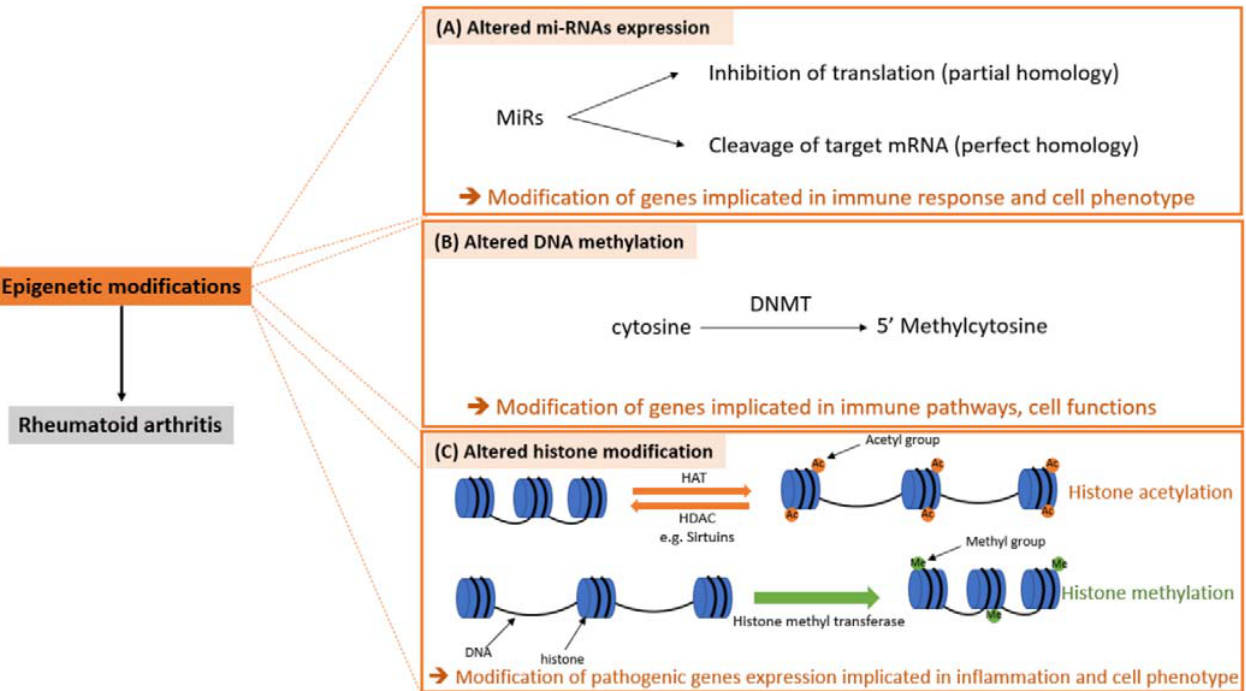
Figure 1. Epigenetic modifications in RA. DNMT: DNA methyl transferase, SF: synovial fibroblast, HAT: histone acetyl transferase, HDAC: histone deacetylase.